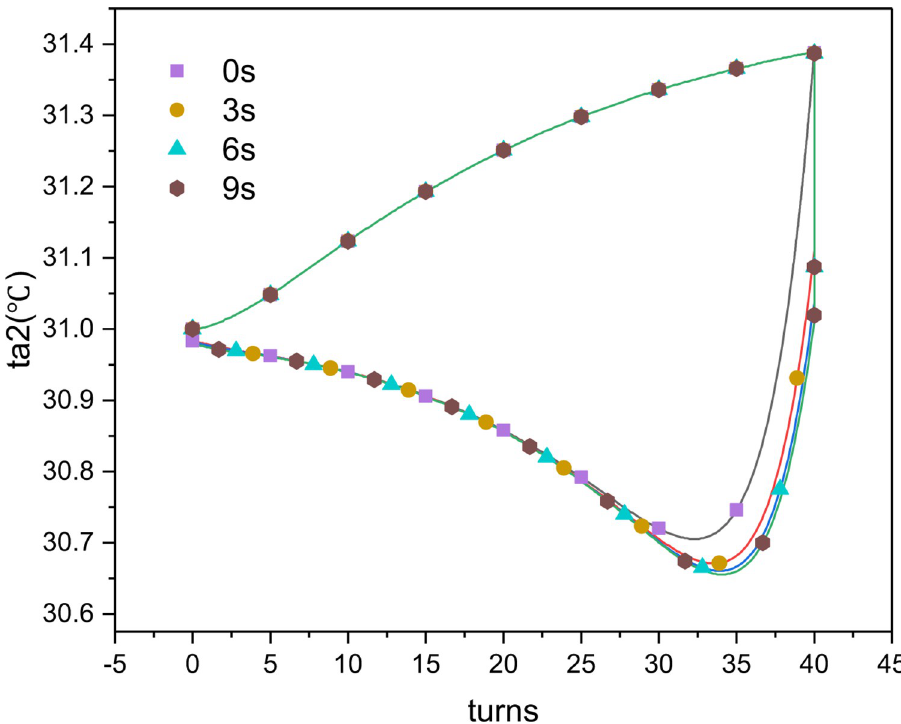
Fig 14. Changes in the simulated air outlet temperature with buffering time during continuous torsion of the nitinol wires ( u = 0.5 m/s, n 1 = 50rpm).